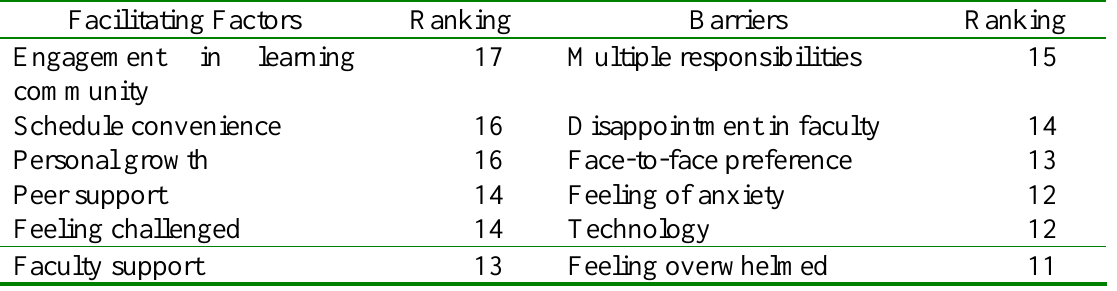
Table 1. Ranking of Most Significant